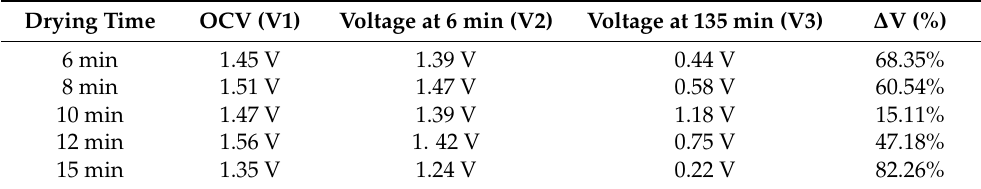
Table 1. The open-circuit voltage (OCV) and discharge voltages of the batteries which were dried at 6 min, 8 min, 10 min, 12 min, and 15 min,